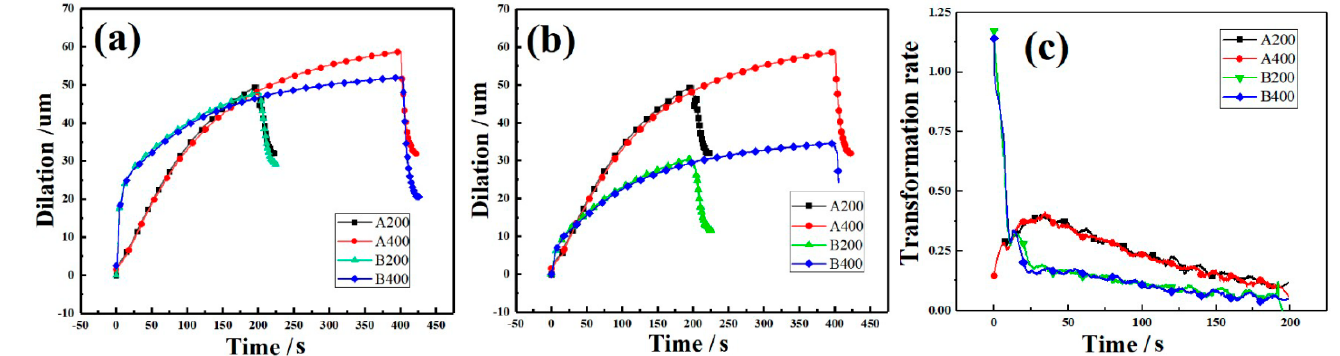
Figure 5. Dilation–time curves: ( a ) the total dilation of bainite and martensite; ( b ) the dilation of isothermal transformation; and ( c ) bainite transformation rate.